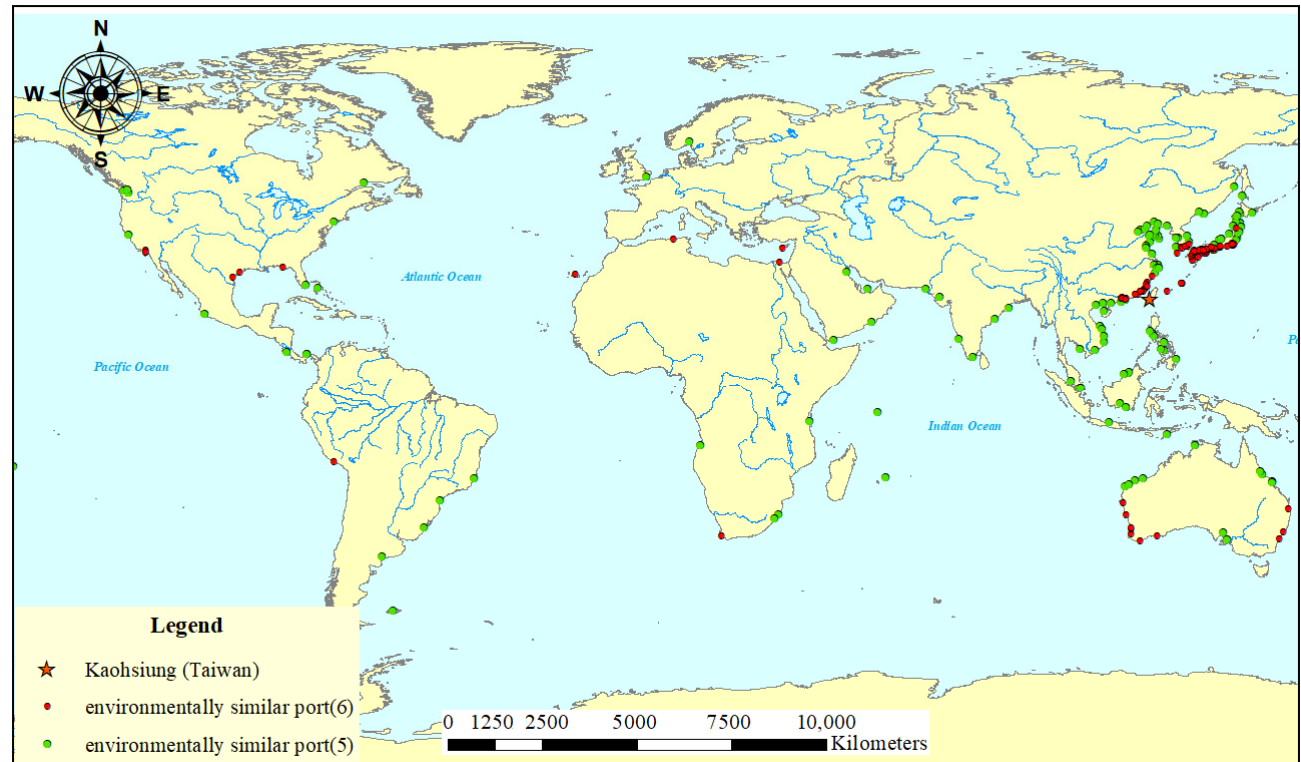
Figure 1. Location of the donor ports with similar environments to the port of Kaohsiung. The red and green solid circles represent ports with a risk score of 6 and 5, respectively, based on the criteria set in Table 1.